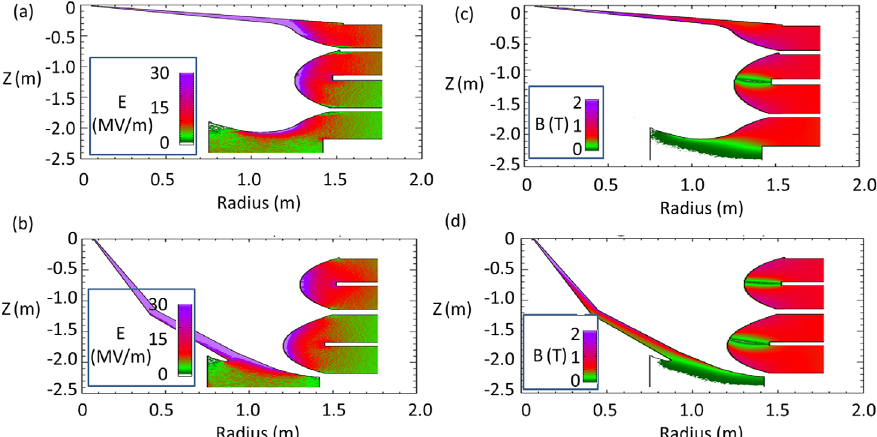
FIG. 18. The amplitudes of the electric (a,b) and magnetic (c,d) fields are plotted for a plane through a cathode vane (a,c) showing the anode-cathode A-K gap and for a plane through an anode vane (b,d) showing the A-K gap along the bottom. The plots are taken in planes through cathode/anode vanes of the CSMITL to illustrate the maximum electric fields and the magnetic nulls between the anode and cathode conductors and the vacuum stack.